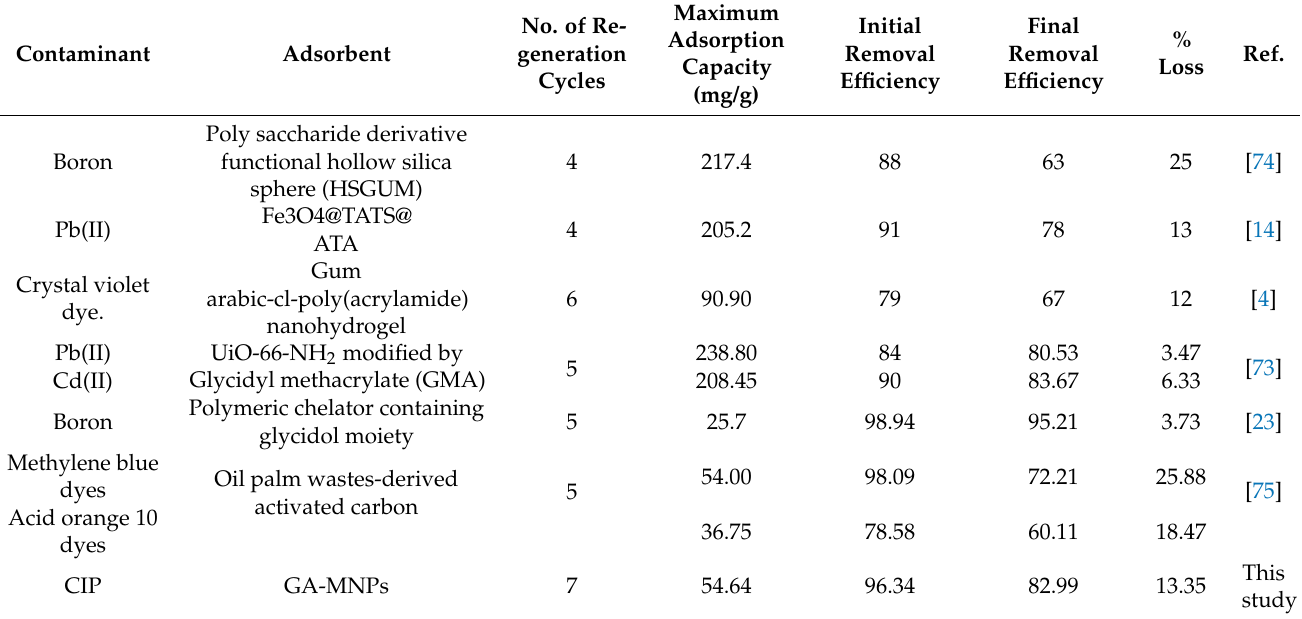
Table 11. Comparison for different adsorbents on regeneration